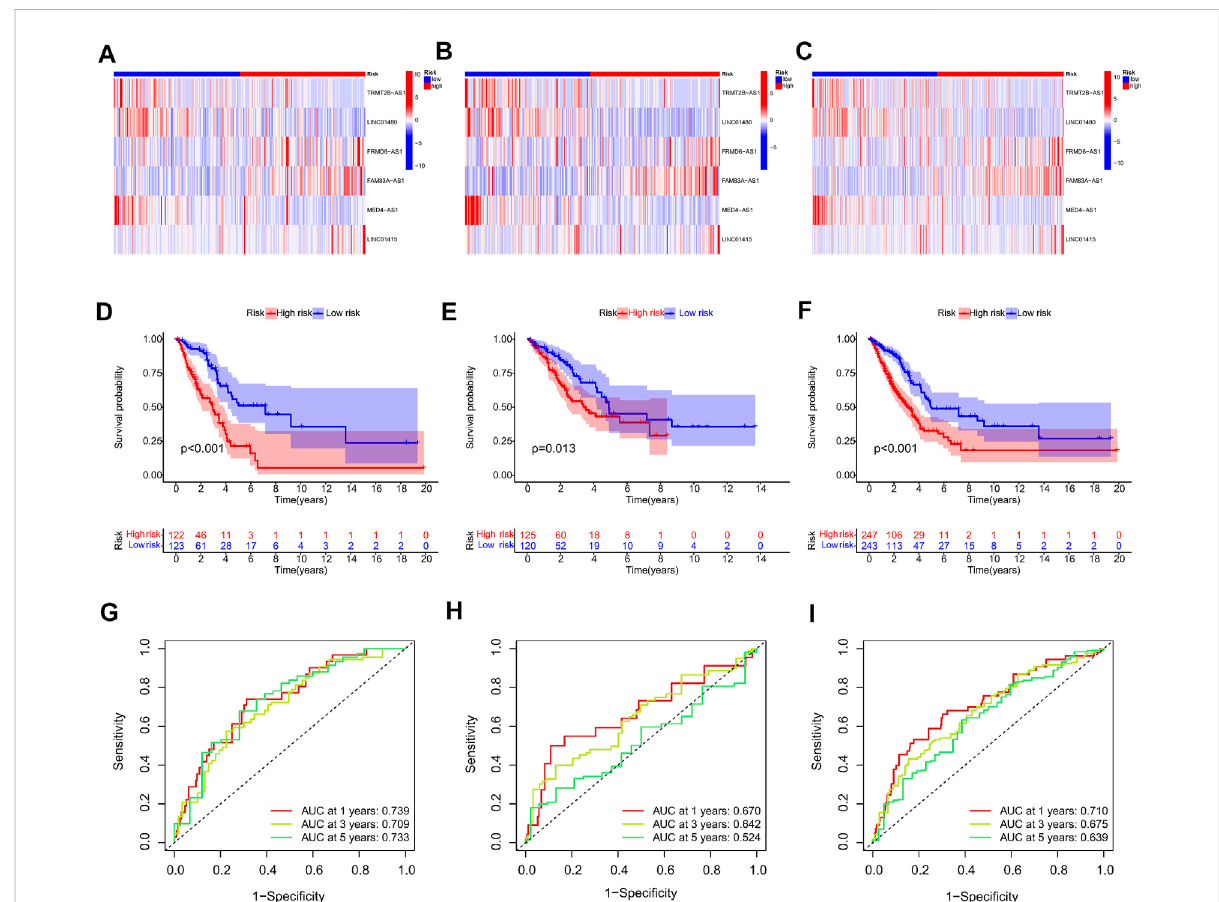
FIGURE 4 Prognosis value of the 6 NRlncRNAs model in the train, test, and entire sets. (A – C) The heatmap of six NRlncRNAs between two groups in the train, test, and entire set, respectively. (D – F) Survival status and time of patients between two groups in the train, test, and entire set, respectively, (G – I) The time-dependent ROC curve of patients between two groups in the train, test, and entire set,